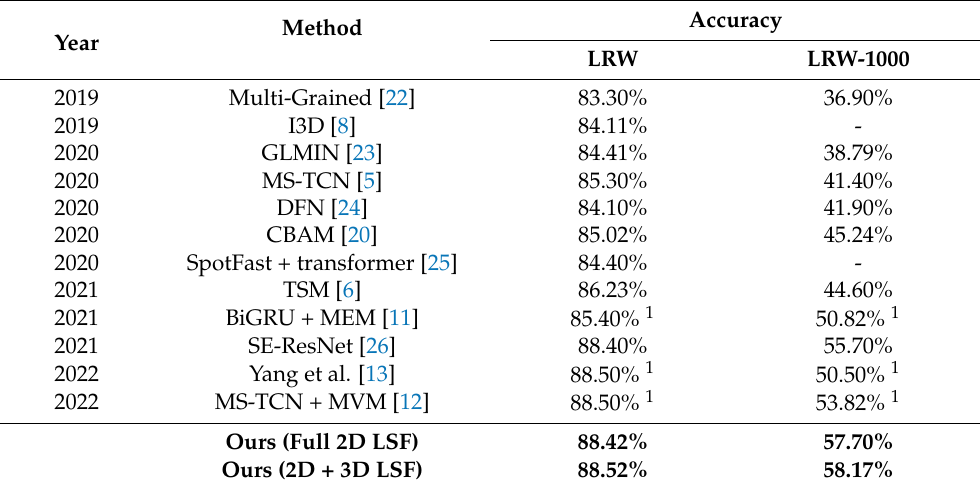
Table 8. Compared with recently excellent works on LRW and LRW-1000 dataset. Results are reported in terms of RANK 1 identification accuracy